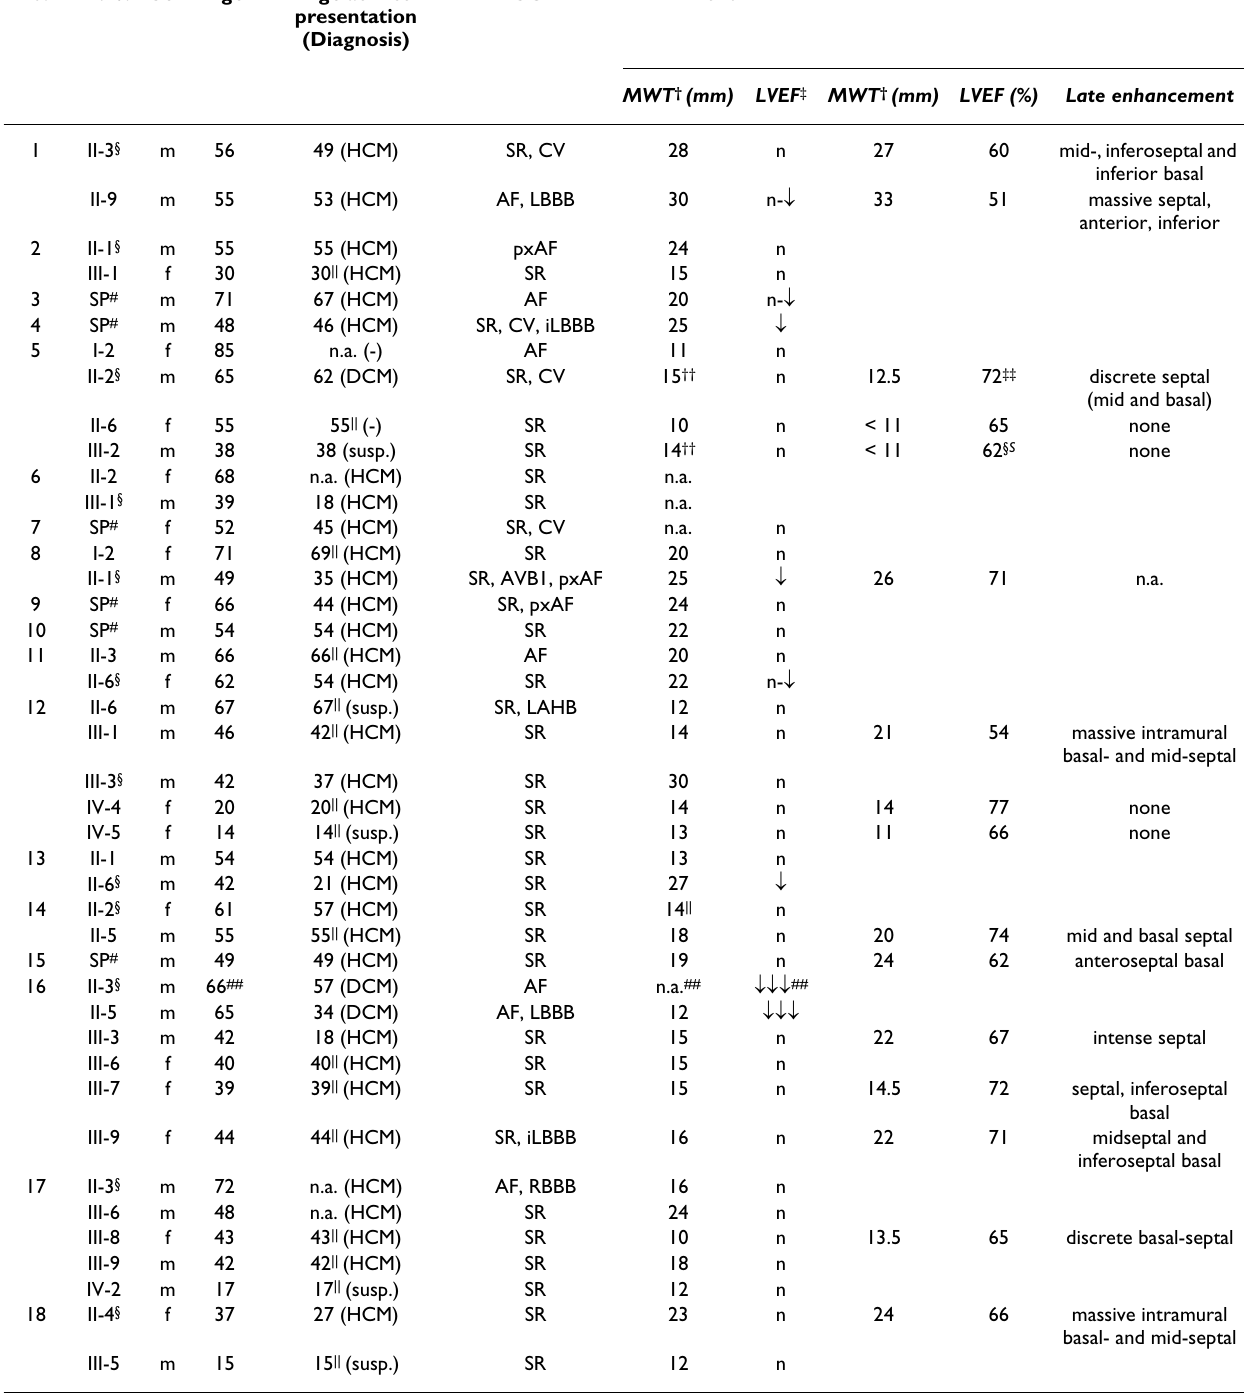
Table 2: Clinical characteristics of mutation carriers No. * Indiv. Sex